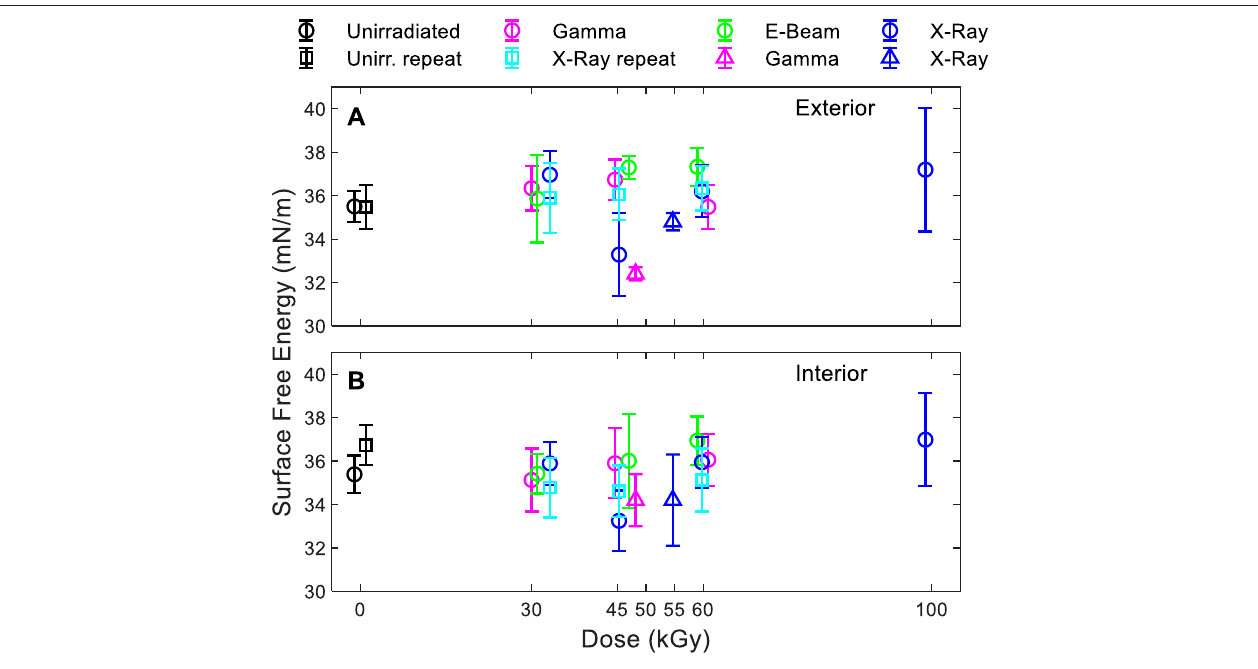
FIGURE 3 | Surface free energy of the (A) exterior and (B) interior side of the bag. Triangles: series #1. Circles and squares: series